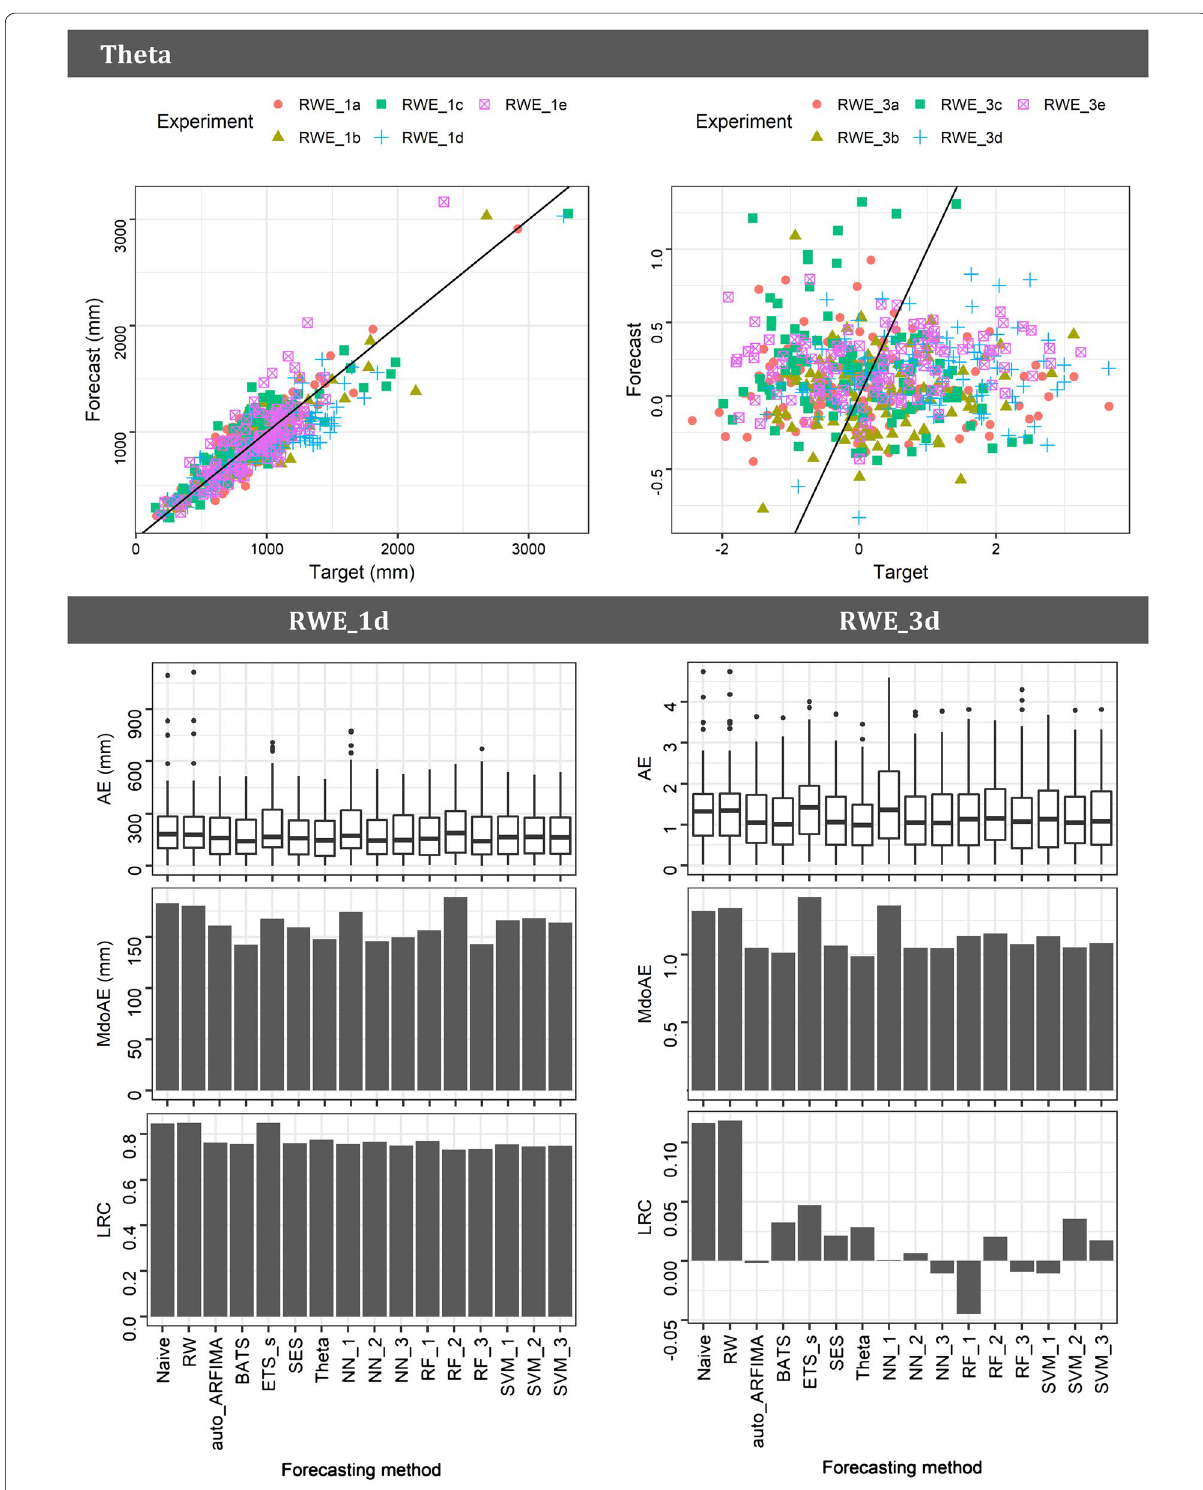
Fig. 3 Comparison in brief between the experiments using the PrecDat and StandPrecDat